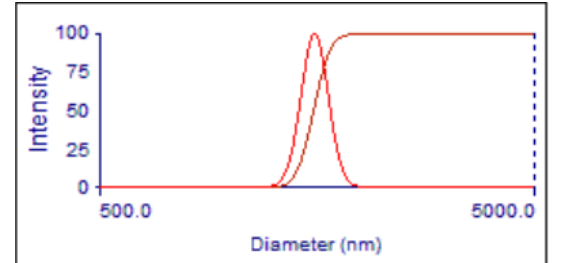
Fig.1: The lognormal size distribution.